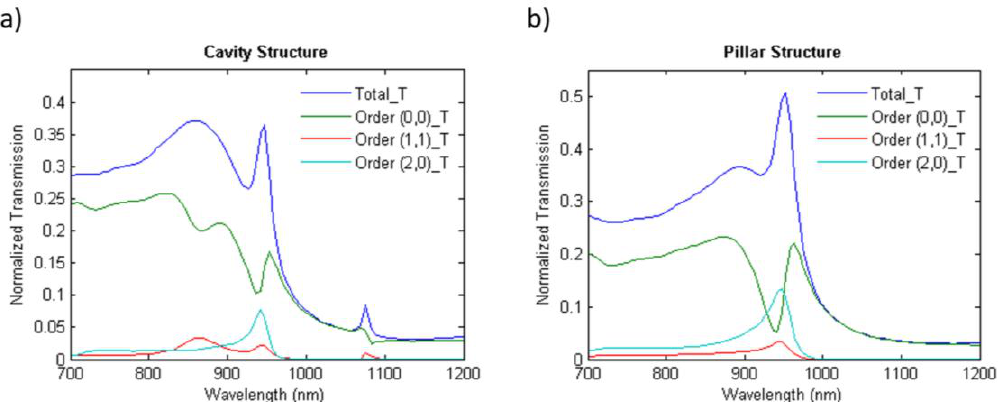
Figure 3. The normalized transmission spectra of simulated patterned ITO structures: ( a ) nanocavity, ( b ) nanopillar. The plot shows the relative power transmitted into different diffracted orders and the net total transmitted power normalized to the simulation source power. Two of the strongest diffracted orders (1,1) and (2,0) are plotted. (0,0) represents the part of incident power not being diffracted by the structures.